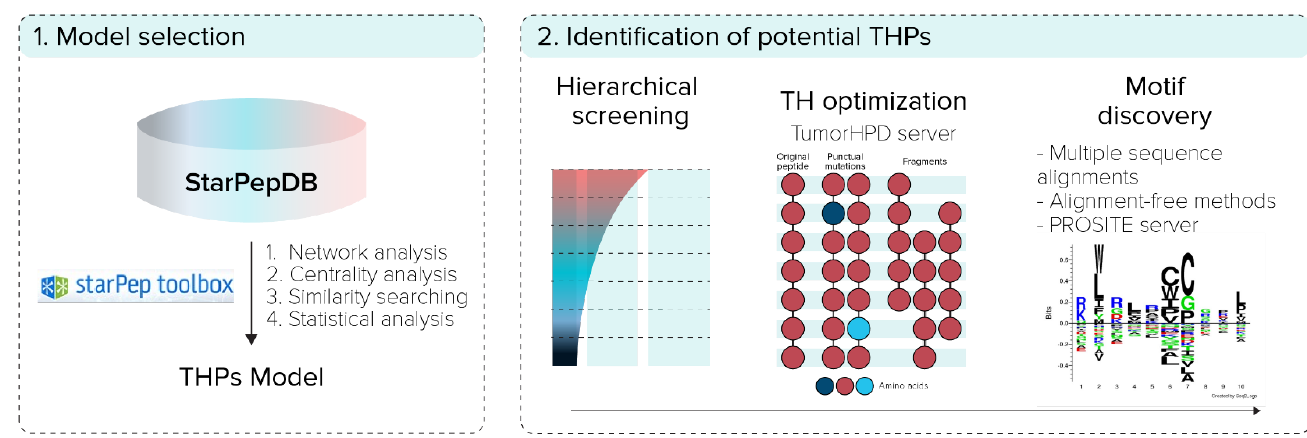
Figure 1. General overview of the experimental procedure.